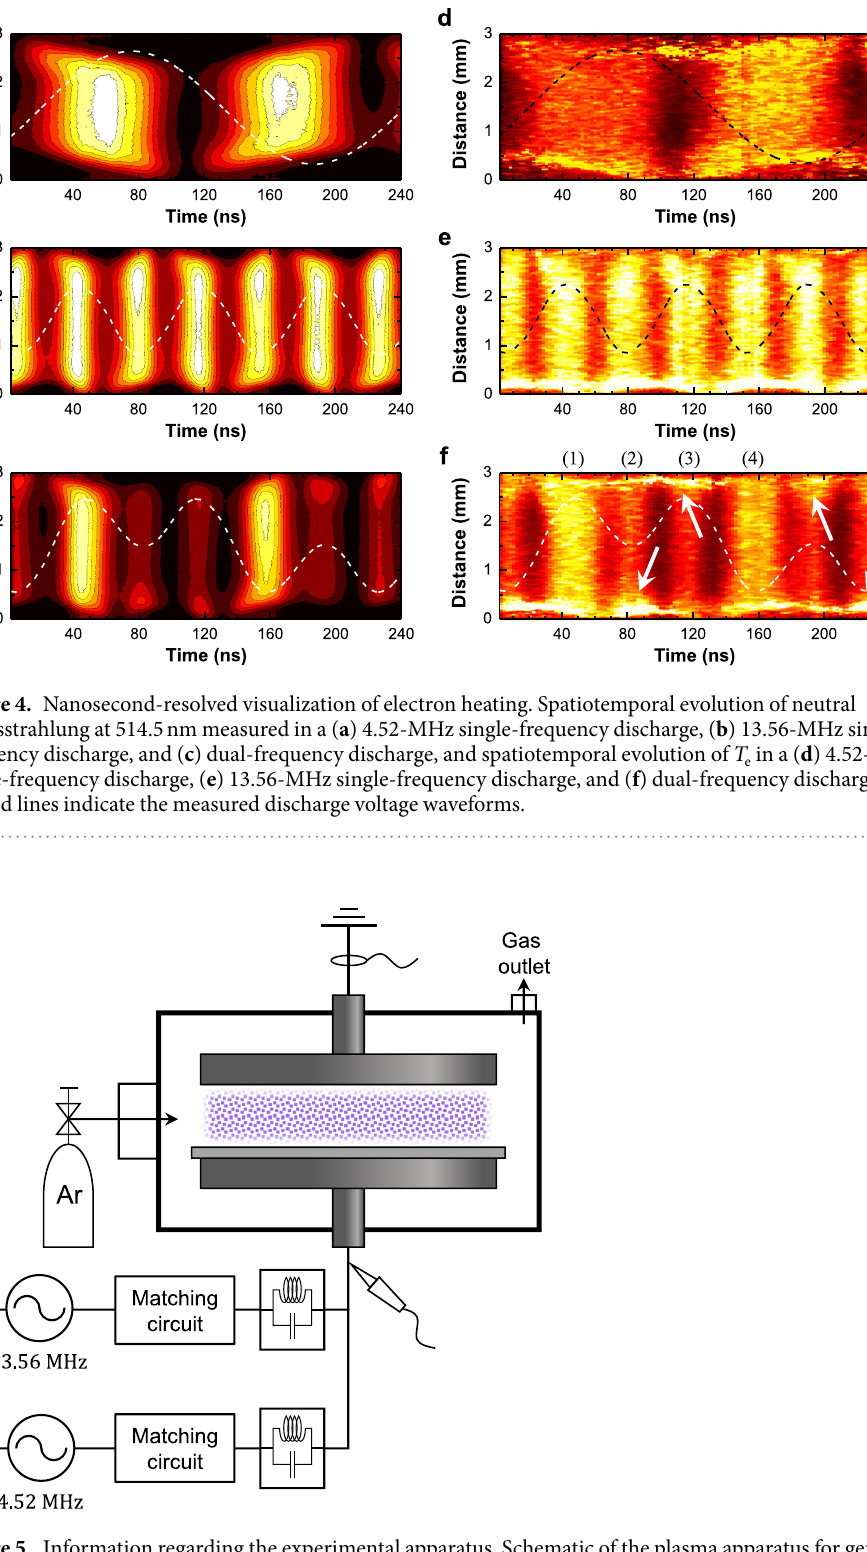
linearly with the input power, are observed with a higher-frequency excited discharge, whereas T e is not strongly